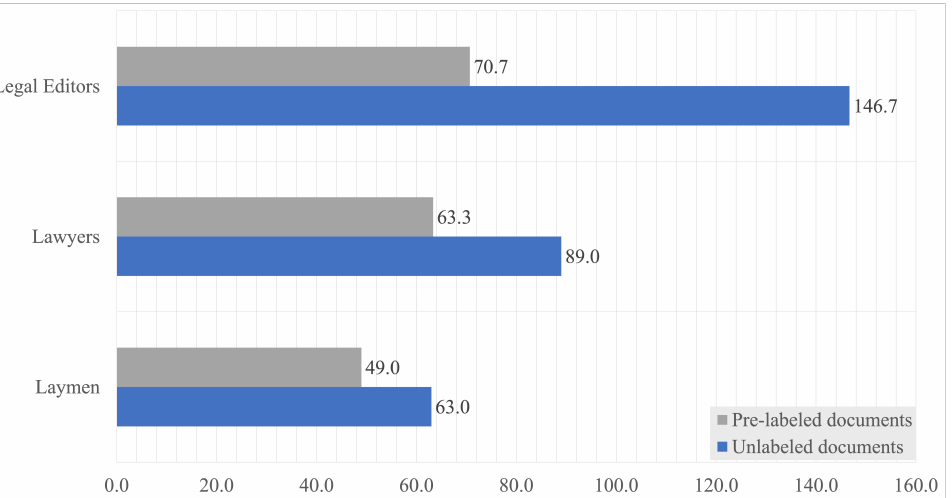
Figure 2. The average number of processed documents in the three examined groups after three hours of